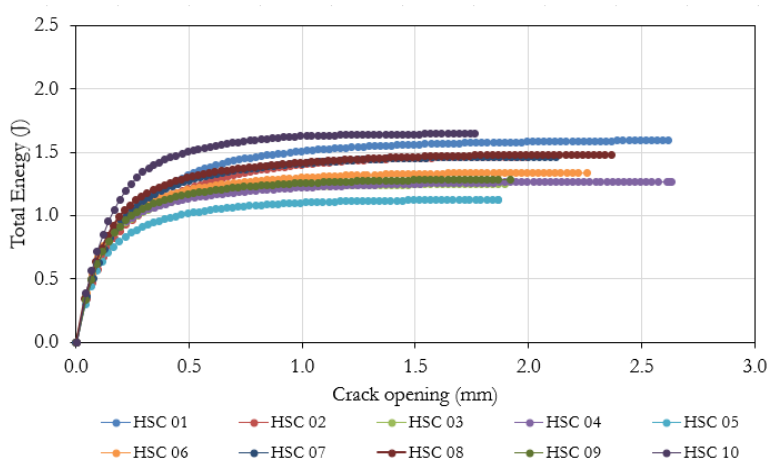
Figure 10. Fracture energy curves for high strength concrete.